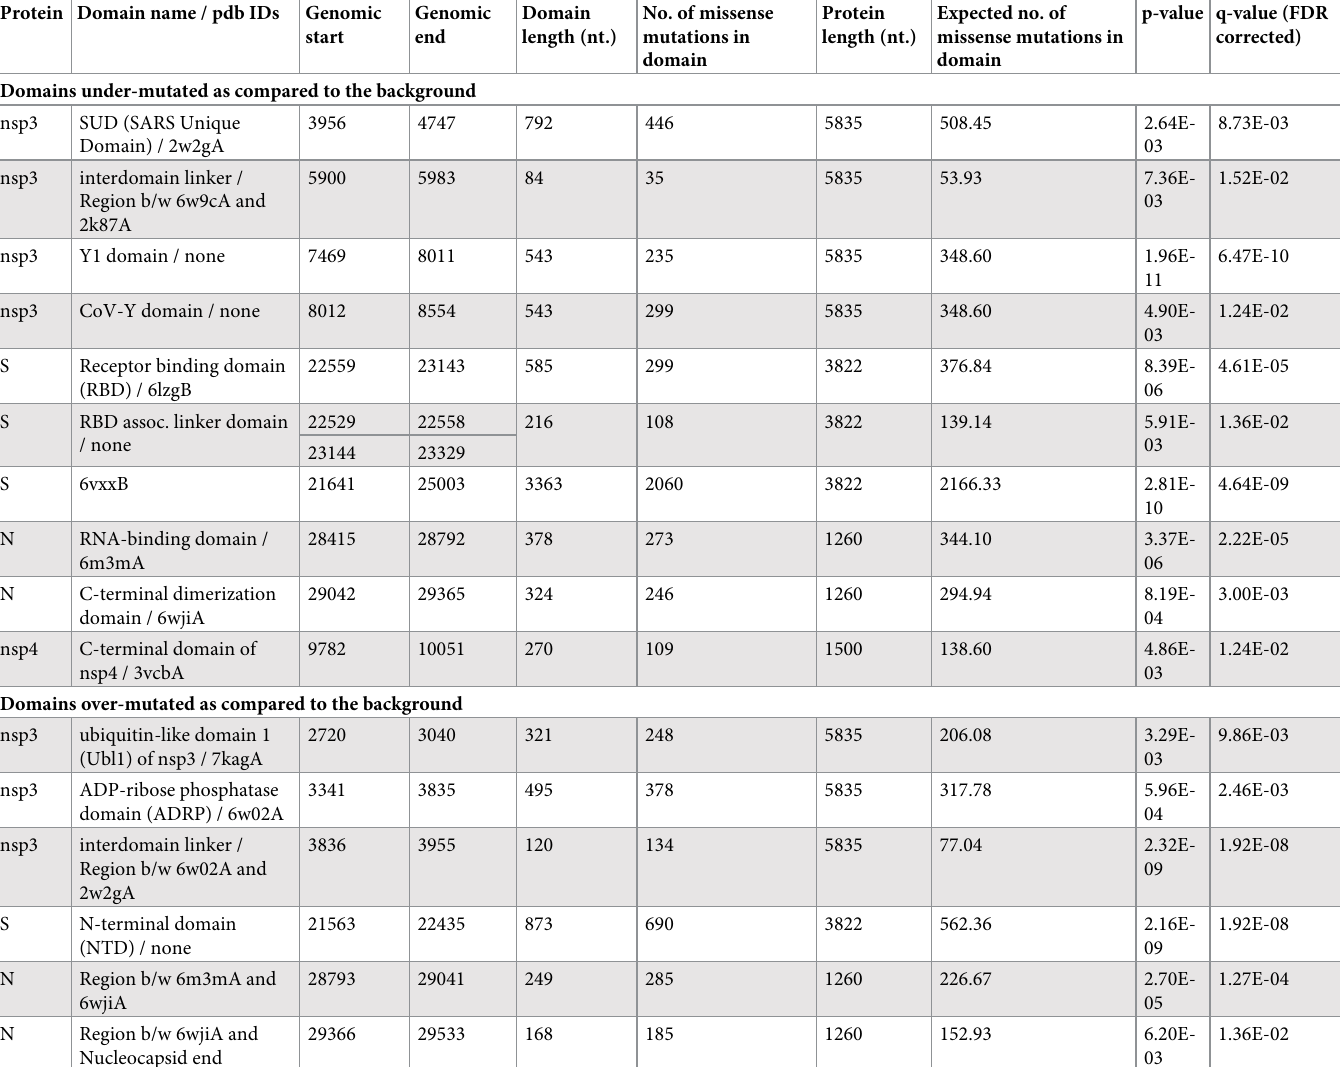
Table 2. Structurally characterized protein domains with rate of mutations significantly different than the background (the encompassing full